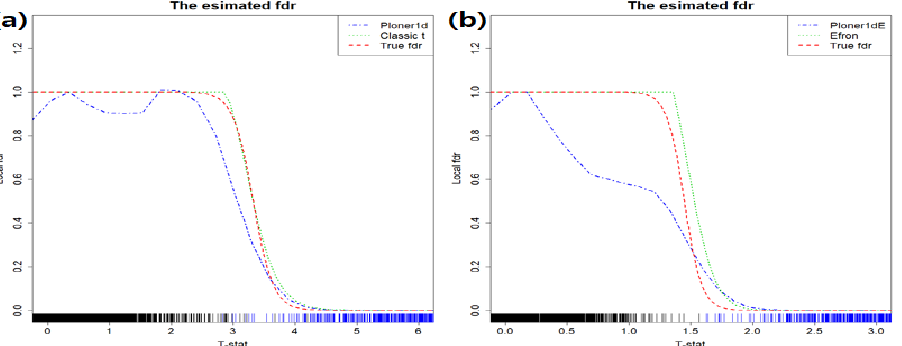
Figure 1. Basic scenario and one-sided alternative. Estimated fdr1ds by using classic t -statistic ( a ) and modified t ( b ). As a reference, true fdr1d is provided in